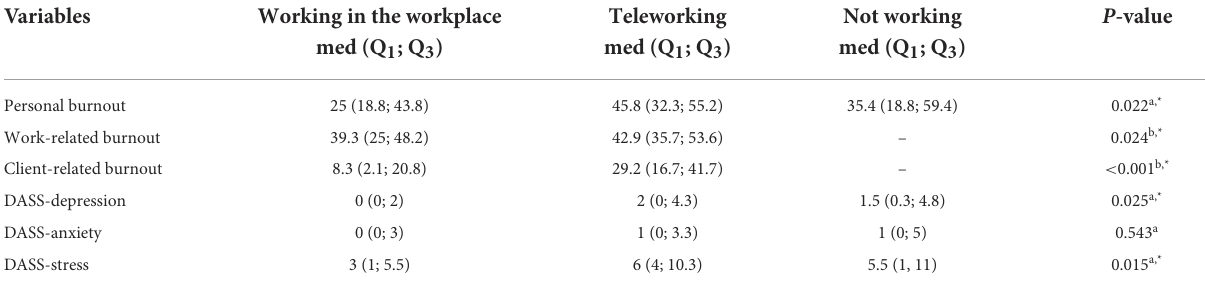
TABLE 2 Burnout, depression, anxiety, and stress levels comparison among three groups of psychologists: those who have been working in the workplace ( n = 21), those who have been teleworking ( n = 50), and those who have not been working ( n = 12).